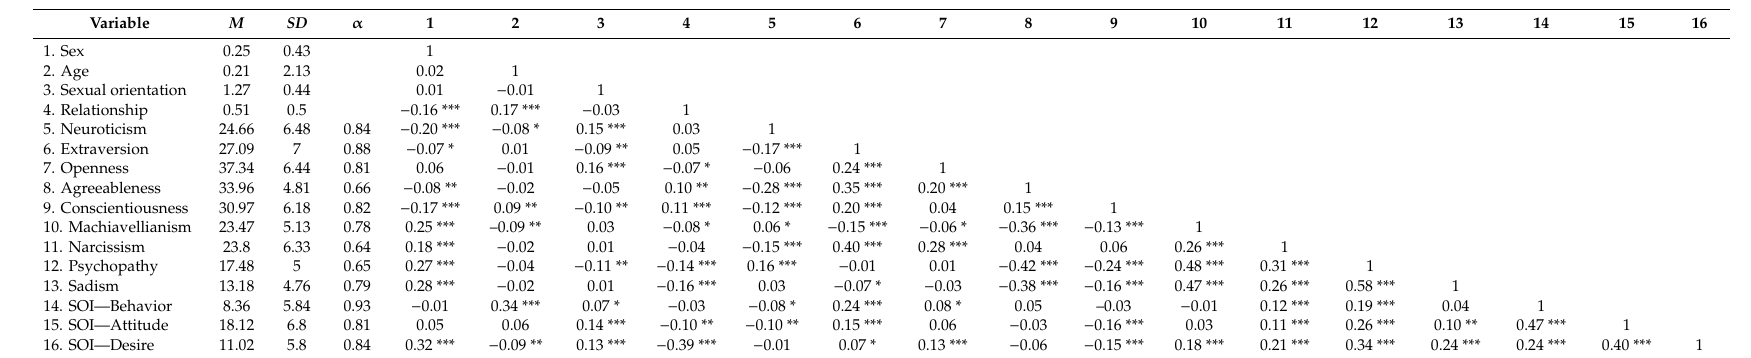
Table 1. Descriptives and correlations.